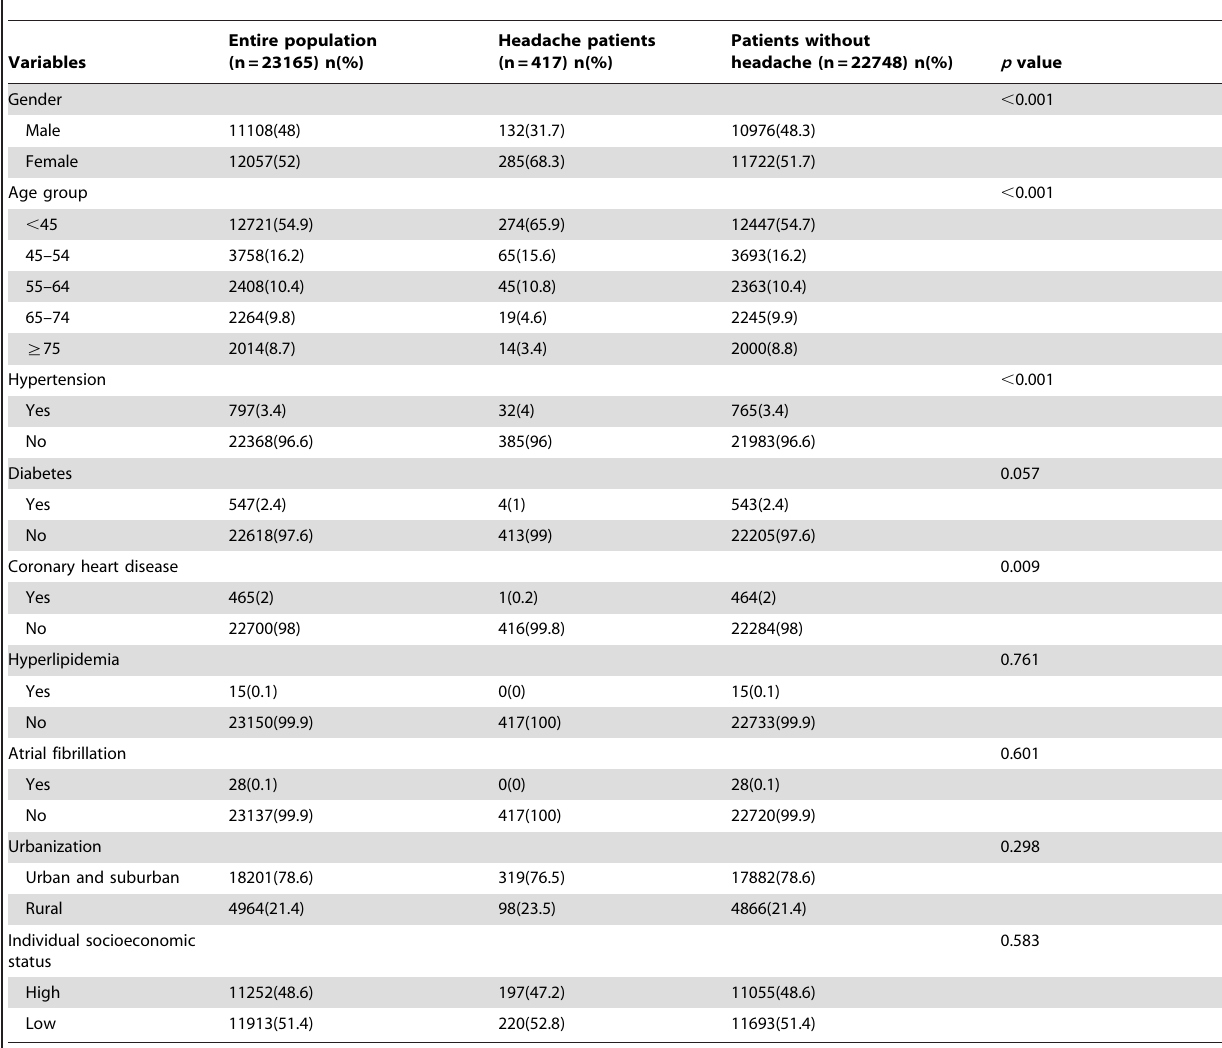
Table 6. Baseline characteristics of ER patients with headache and patients without